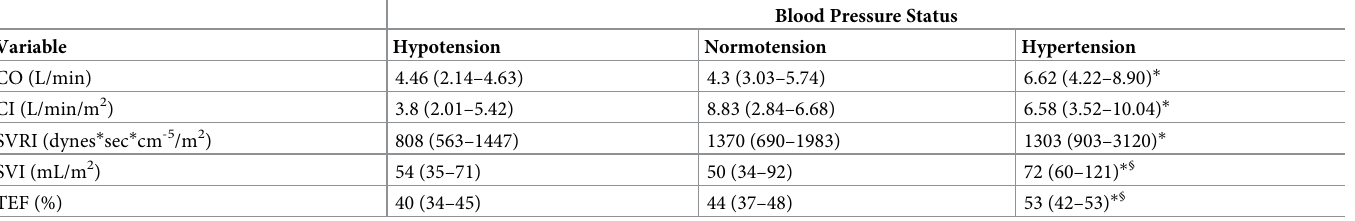
Table 2. Median (min-max) values for cardiac variables measure with UDCO in six, isoflurane anesthetized, mature alpacas during isoflurane induced hypotension, normotension and phenylephrine infusion (0.5–3 mcg/kg/min) induced hypertension. Hypotension was defined as a mean blood pressure between 45 and 55 mmHg, normotension was defined as a mean blood pressure between 65 and 75 mm Hg and hypertension was defined as a mean blood pressure greater than 85